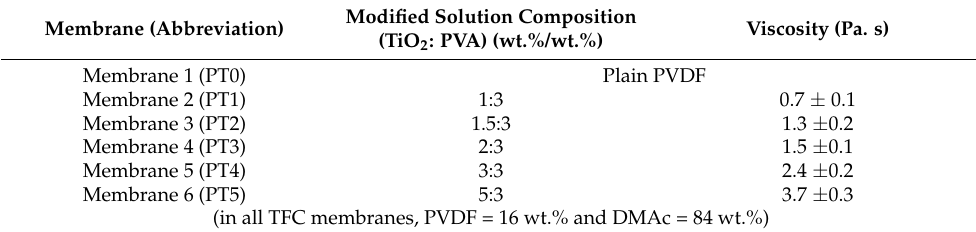
Table 2. Composition of TFC membranes and the viscosity of coating solutions (TiO 2 /PVA). Membrane (Abbreviation)